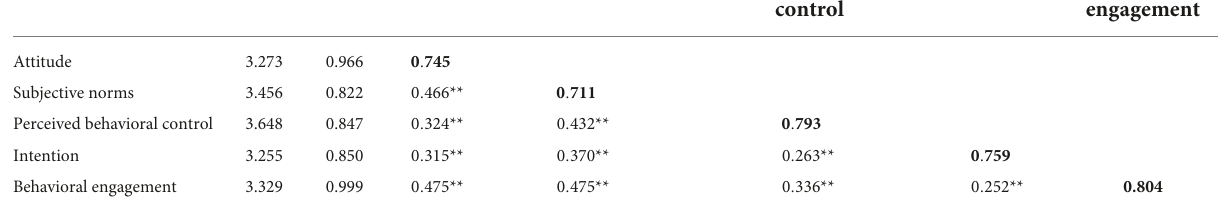
TABLE 2 Validity of potential variables.